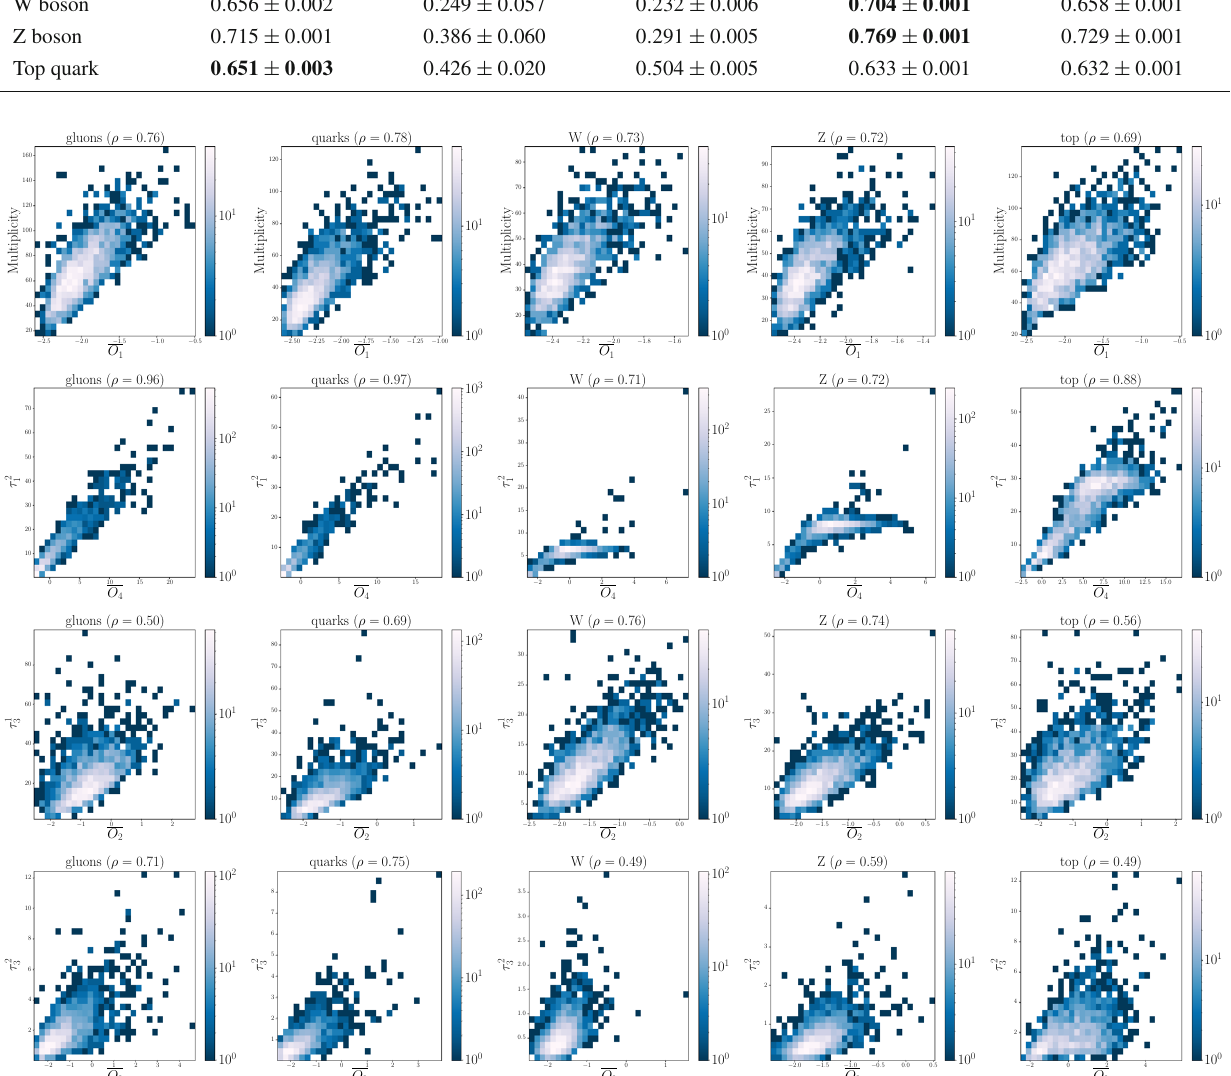
Fig. 9 Two-dimensional distributions between (top to bottom) O 1 and constituents multiplicty, O 4 and τ for jets originating from (right to left) gluons, light flavor quarks,W